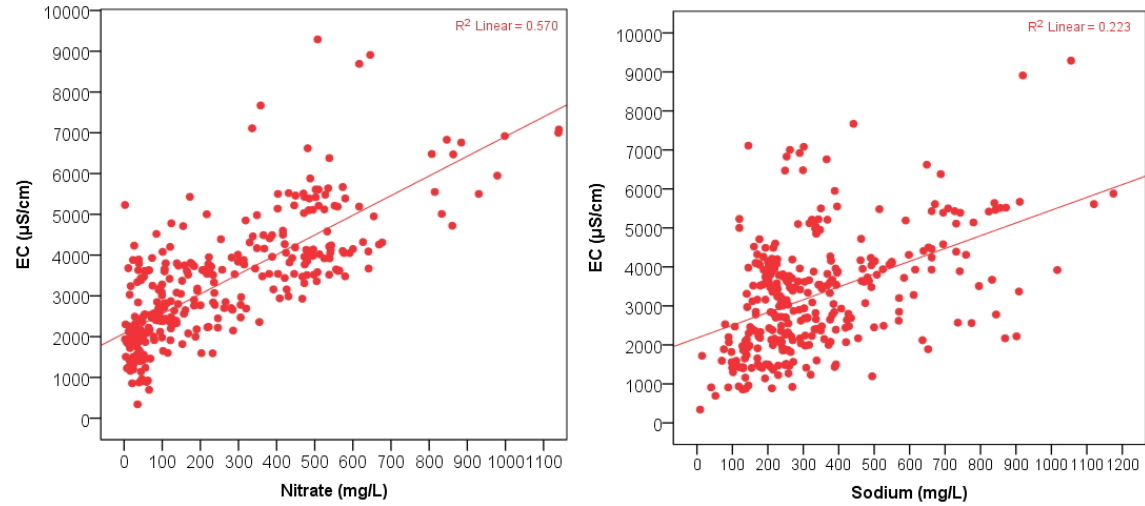
Figure 8. Scatter plot diagram for EC-NO 3 − and EC-Na + . Table 4. Loadings of the variables on three significant principal components. Rotated Component Matrix